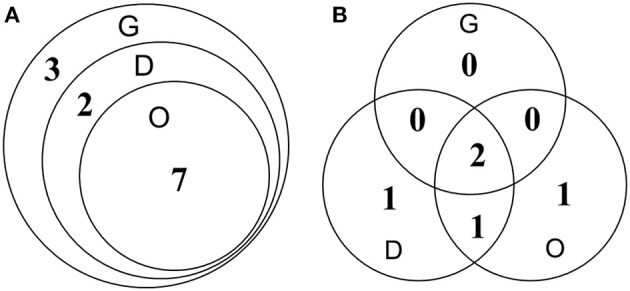
Detection of GI HuNoVs in retail oyster samples by ISC-RT-qPCR (A) and RT-qPCR (B). G, gills; D, digestive glands; O, residual tissues. Numbers represented number of the positive samples in the overlapped area and non-overlapped area.